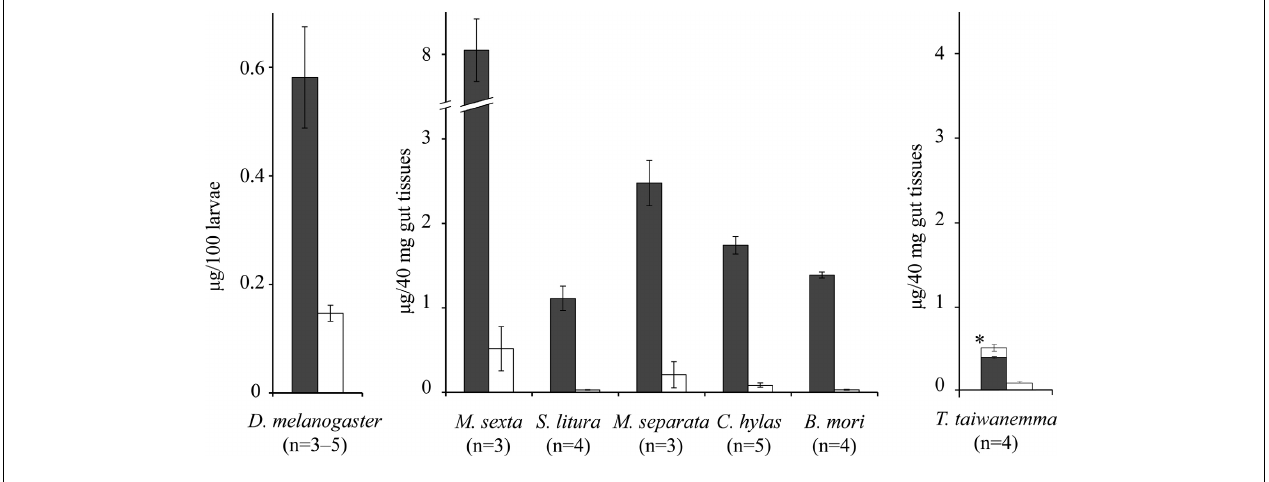
FIGURE 2 | The amounts of FACs synthesized in vitro (Mean ± s.e.m.). The amounts of conjugates synthesized by fresh midgut tissues of Lepidoptera species and Teleogryllus crickets, or whole Drosophila larval